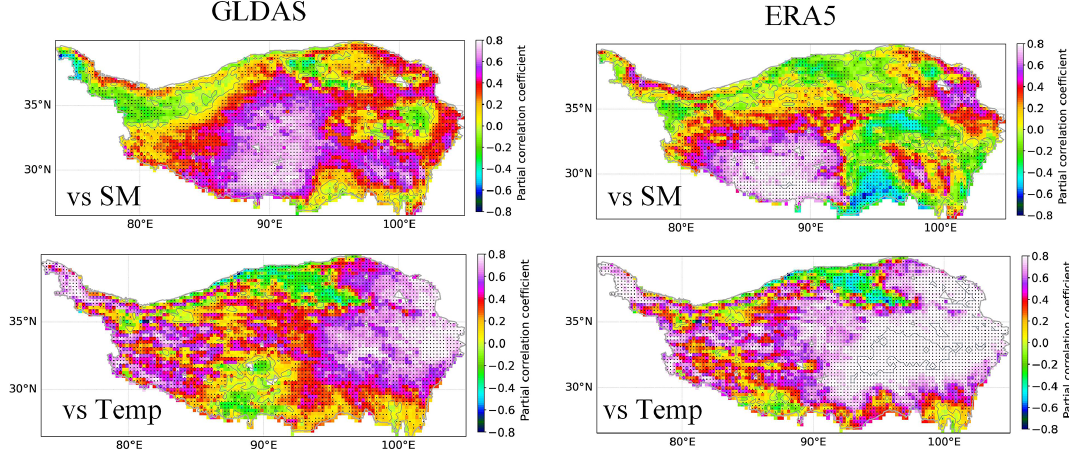
Figure 12. Spatial distribution of the partial correlations between the NDVI and soil moisture (SM) or surface air temperature (Temp) over the summer period of May–September from 1982 to 2015 for GLDAS and ERA5, respectively. The black dots denote the significant correlations.